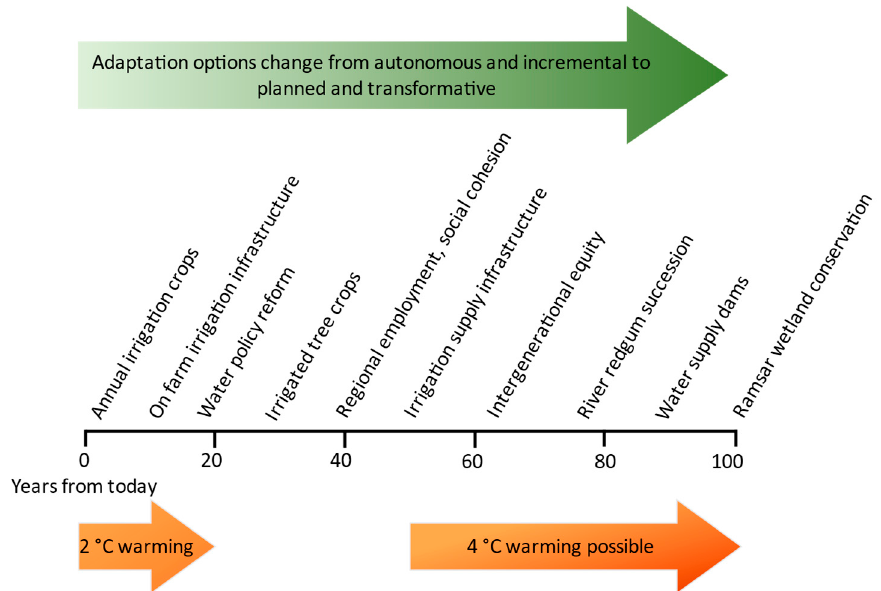
Figure 5. Timeline illustrating the conceptual lifetimes of different types of decisions, compared with the timescales for warming, and the changing types of adaptation. Adapted from [84] to show Basin water management examples.